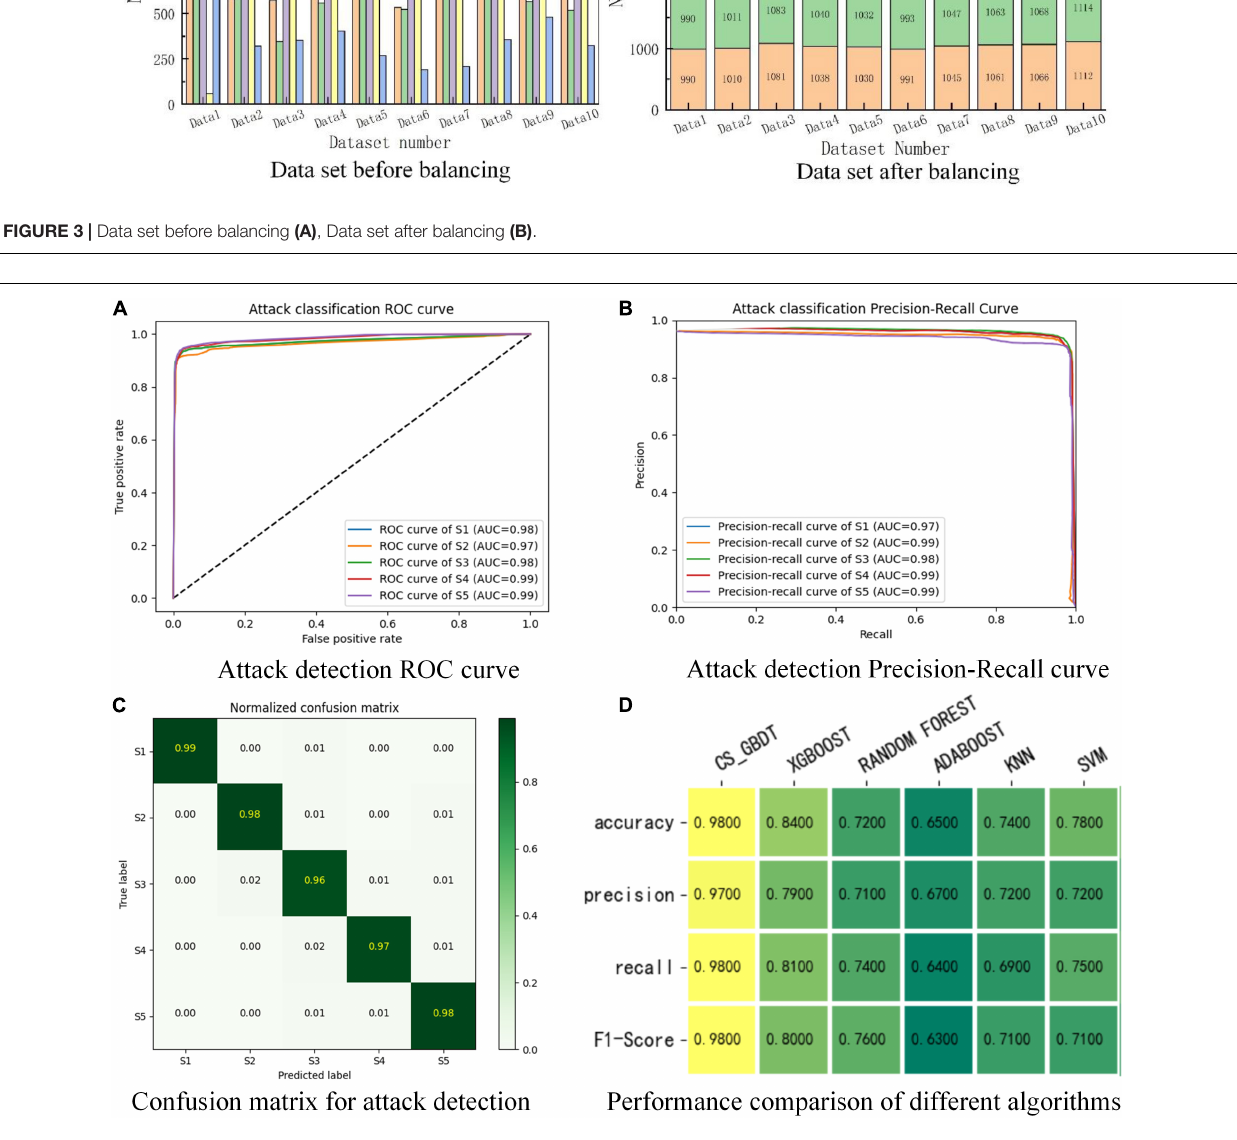
FIGURE 4 | Attack detection receiver operating characteristic (ROC) curve (A) , Precision-Recall curve (B) , Confusion matrix (C) , and Performance comparison (D) . AUC, area under the ROC curve; CS-GBDT, CS gradient boosting decision tree; KNN, K -nearest neighbors; SVM, support vector machine.